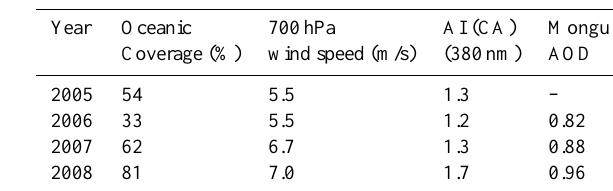
Table 2. September average ocean coverage, wind speed and aerosol source